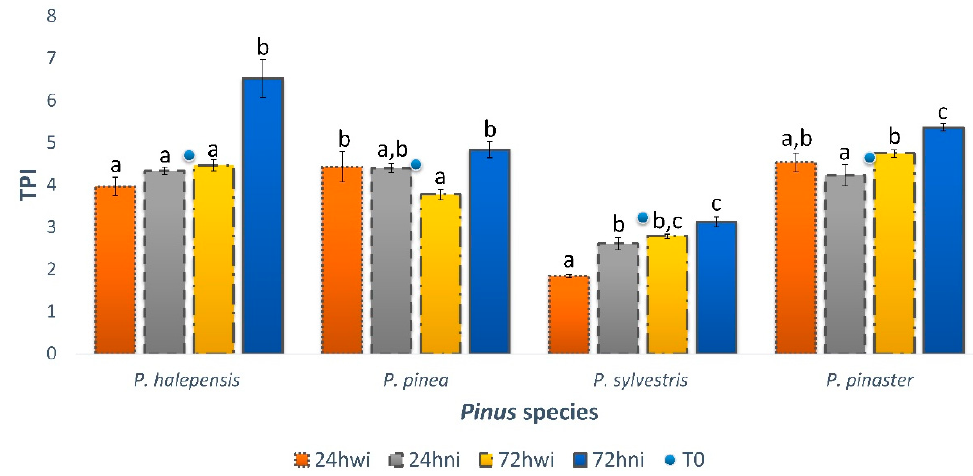
Figure 1. Total phenolic index (TPI) in the branch tissues of 12-year-old P. halepensis, P. pinea, P. sylvestris , and P. pinaster before (T0), 24 h, and 72 h after water-inoculation (wi) and Bursaphelenchus xylophilus- inoculation (ni). Lowercase letters indicate significant differences between treatments and time in the four pine species (one-way ANOVA). Error bar indicates mean ± SE. Mean values (N = 3).